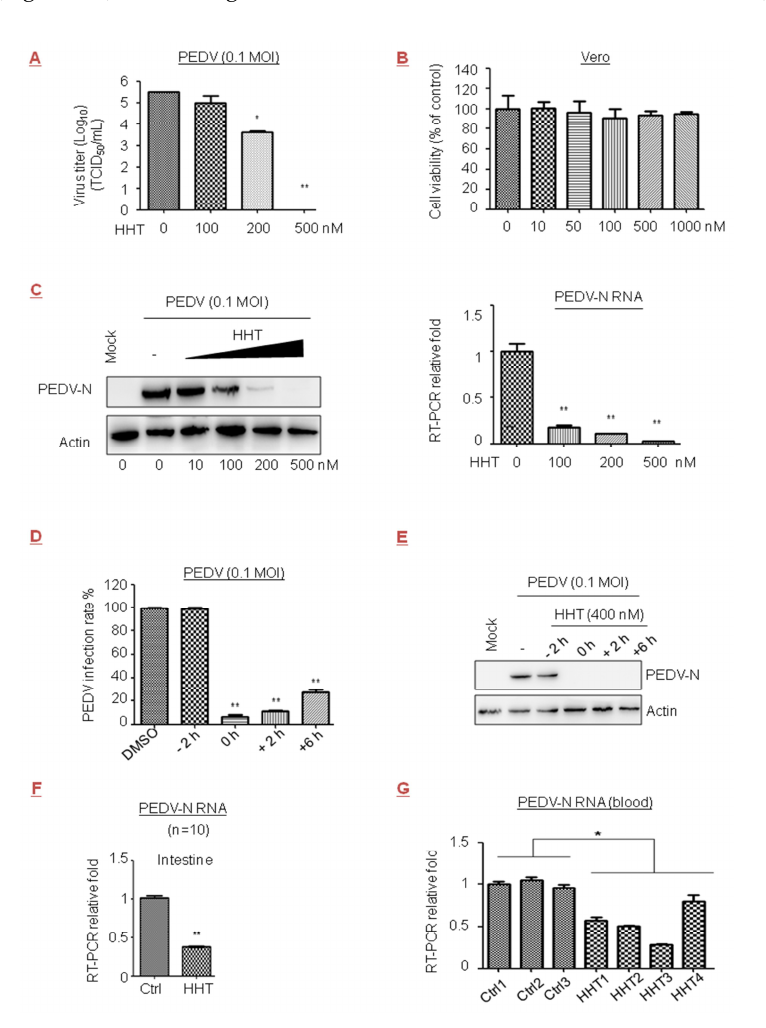
Figure 3. Inhibitory effect of HHT on porcine epidemic diarrhea virus (PEDV) infection in cells and piglets. ( A – C ) Dose-dependent studies. Vero cells seeded at 2.5 × 10 6 cells per well in six-well plates were infected with PEDV at 0.1 MOI in the presence of the HHT at different concentrations for 48 h. Viral yields in the medium were determined by TCID 50 . These experiments were performed two times with three replicates in each experiment. Values represent means and SD. Statistical analysis was evaluated by one-way analysis of variance with Dunnett’s multiple-comparison test. * p < 0.05; ** p < 0.01 compared to PBS-treated group ( A ). Effects of HHT on Vero cell viability were determined, and assessed as indicated in Figure 1B ( B